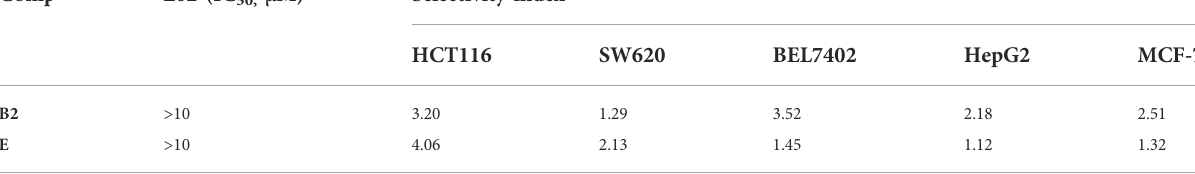
TABLE 2 In vitro cytotoxic of compounds B2 and F against normal cell line (L02) a .